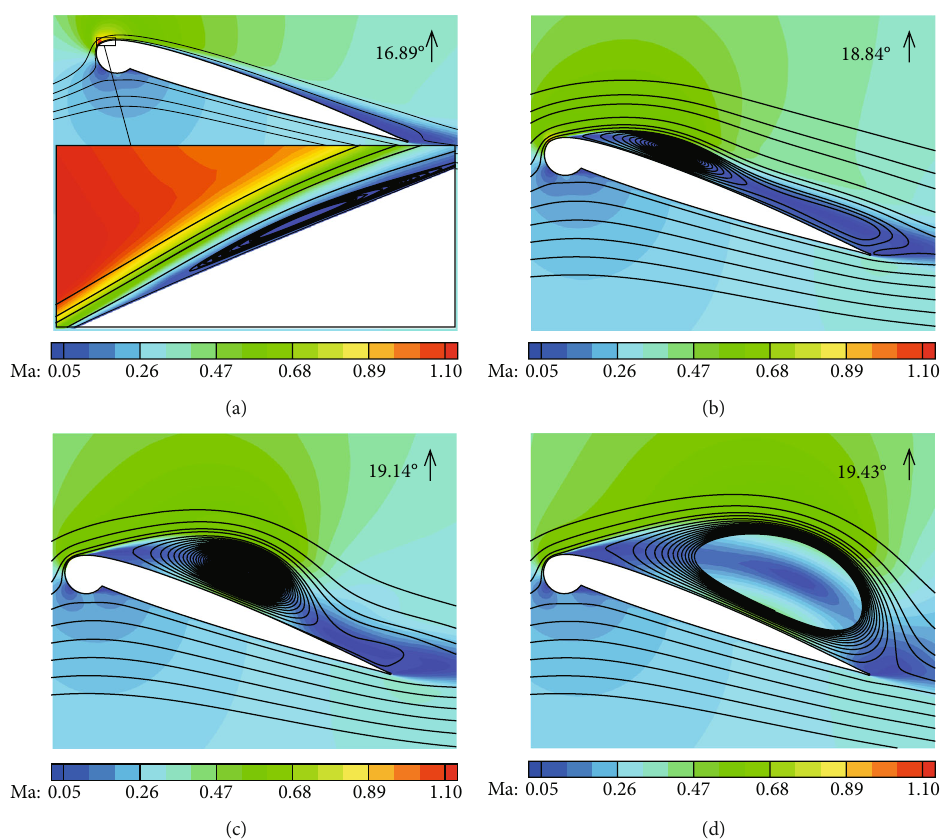
Figure 35: Streamlines and Mach number contours of the ILE airfoil in Case 8 at di ff erent angles of attack